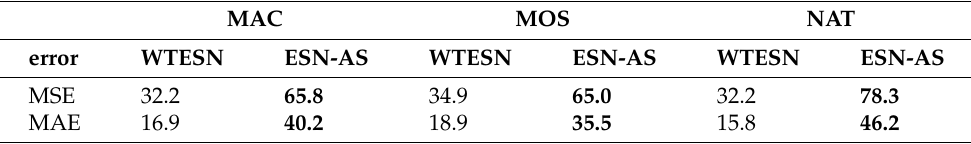
Table 9. Gains (%) over Persistence—MAC, MOS and NAT. MAC MOS